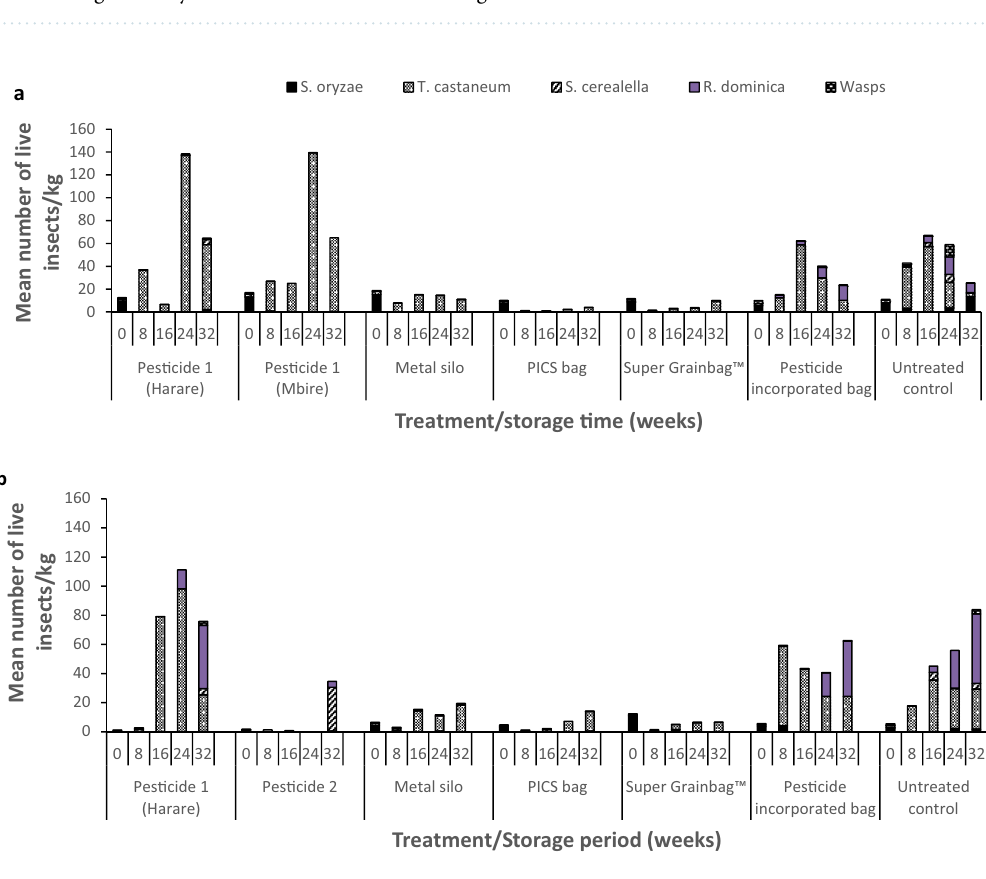
Pesticide 1 containing fenitrothion and deltamethrin (Fig. 3a,b), whilst S. cerealella population build-up was more pronounced in Pesticide 2 (containing pirimiphos-methyl and thiamethoxam) and untreated control treat- ments. Population growth of the insect-pests T. castaneum and R. dominica were more pronounced in deltame- thrin-incorporated polypropylene storage bags and untreated control. The insect population build-up started from four months of storage (16 weeks) in synthetic pesticide treated grain (Fig. 3a,b). Sitophilus oryzae failed to develop significantly during the course of the experiment. Live adult S. oryzae were found at 32 weeks storage (during the winter months of May), when mean monthly temperatures at the experimental site had dropped to ~ 30 °C. The hermetic treatments (PICS bags, Super Grainbags and metal silos) suppressed pest build-up during the full length of the two storage seasons, but small T. castaneum populations managed to develop in some metal silos and PICS bags. Massive amounts of moth webbing were observed in the untreated control and Pesticide 2 but only low numbers of moths were actually recorded during sampling. Development of T. castaneum was relatively low in untreated control where R. dominica and S. cerealella populations developed (Fig. 3b).